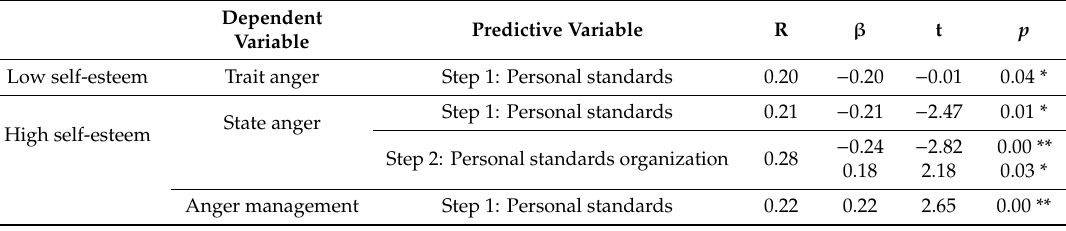
Table 3. Linear regression analysis